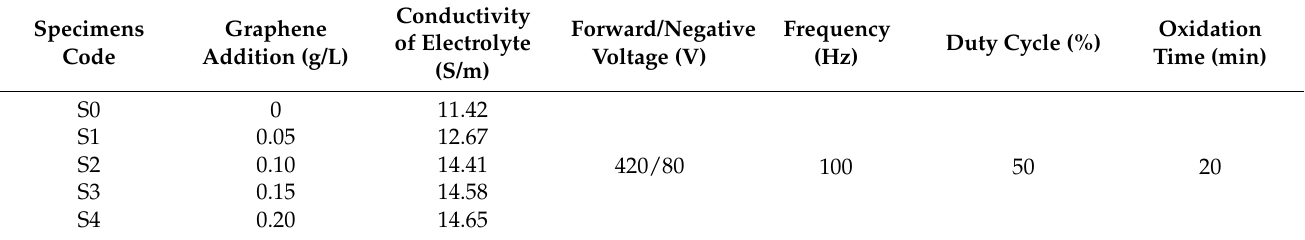
Table 2. The specimens code and MAO